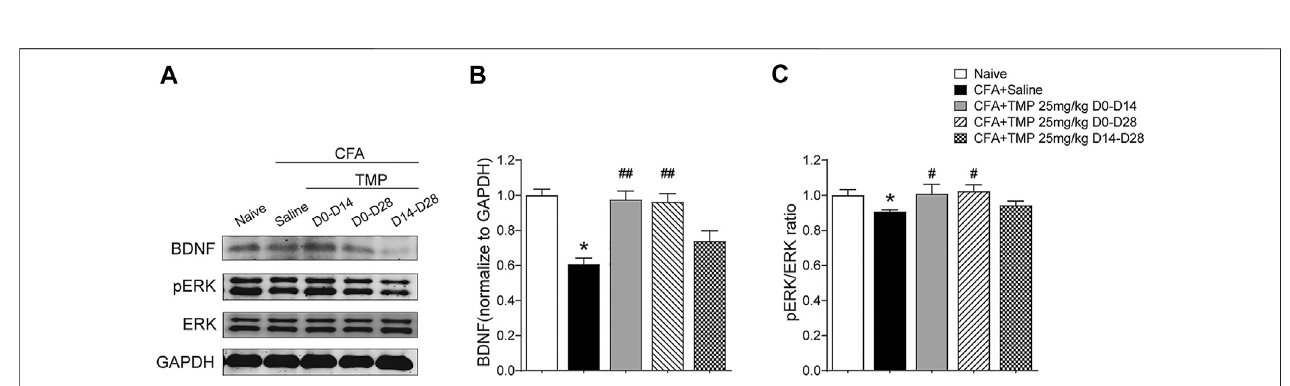
FIGURE 10 | Time dependent effects of TMP on hippocampal BDNF/ERK expression in CFA induced in fl ammatory pain. (A – C) Levels of hippocampal BDNF (B) and pERK/ERK ratio (C) with different TMP administration periods (25 mg/kg, i.p. D0 – D14, D0 – D28 and D14 – D28 vs. saline). Statistical analysis was performed by one way ANOVA, followed by Dunnett ’ s multiple comparisons (* p < 0.05, vs. Naïve; # p < 0.05, ## p < 0.01, vs.